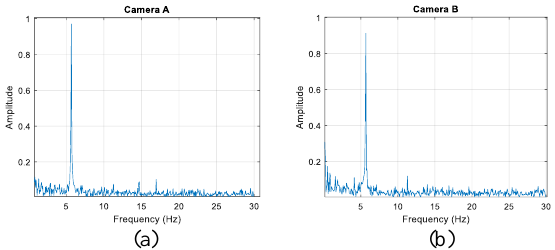
Figure 9. Frequency analysis of measured vibration: (a) Camera